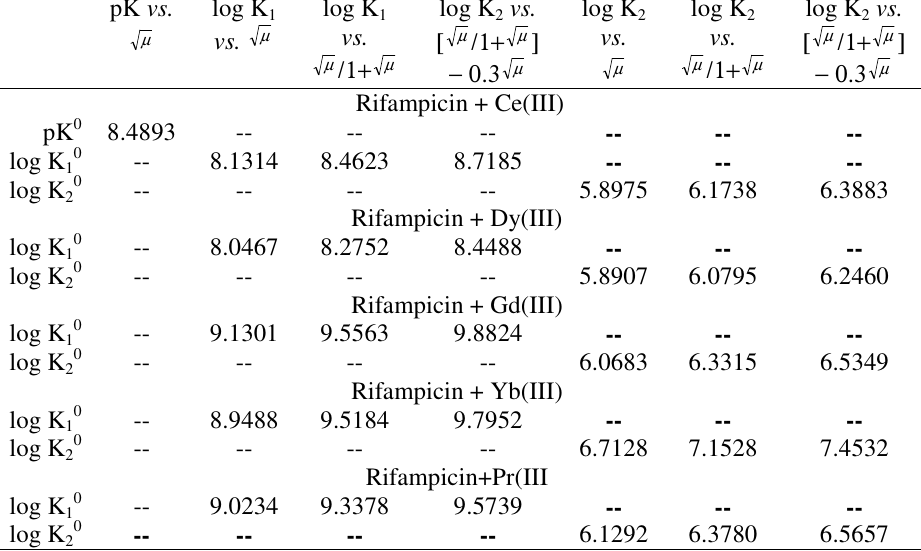
Table 2. Thermodynamic stability constant (pK 0 and log K 0 ) values for Ce(III), Dy(III), Gd(III),Yb(III) and Pr(III) metal ions with rifampicin pK